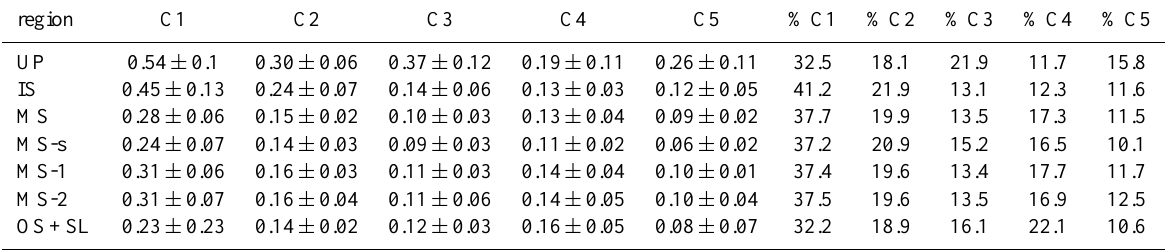
Table 3. Mean of the five fluorescence components identified by the PARAFAC model in the different regions (IS-inner shelf, MS-middle shelf, OS+SL-outer shelf/slope, UP-Unimak Pass) of the Bering Sea. In addition, in the middle shelf mean values of fluorescence compo- nents at surface (MS-s), mid-1 (MS-1) and mid-2 (MS-2) depths are also shown. Percentage compositions of the components are given for each of the regions.